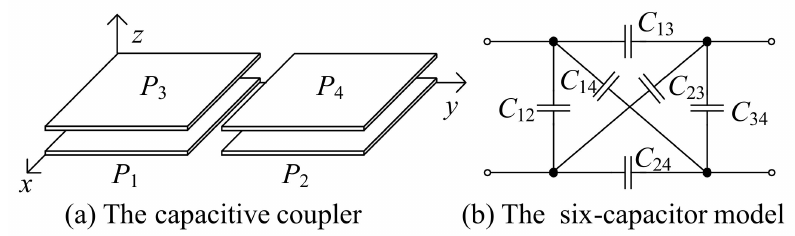
Figure 1. A typical structure of the capacitive coupler and its six-capacitor model.